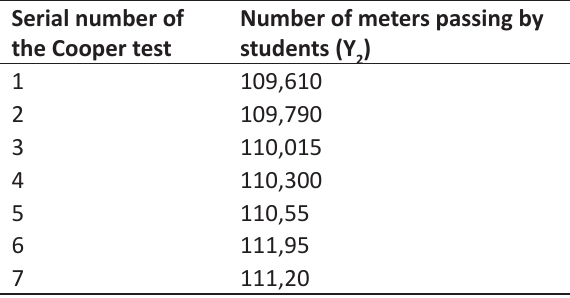
Table 2. Results of the Cooper test for the experimental